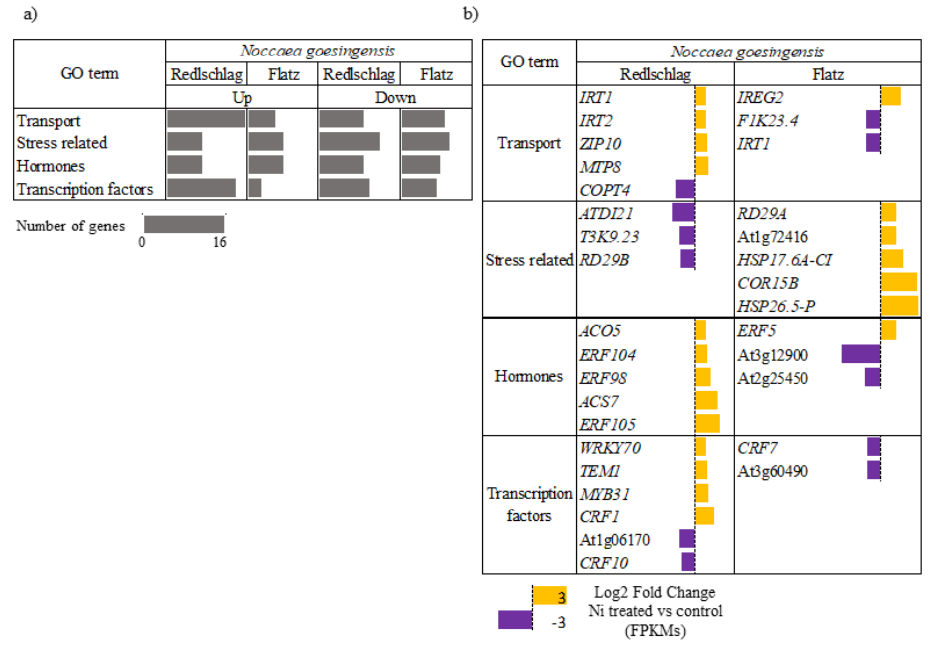
Figure 4. Gene expression analysis of two Noccaea goesingensis ecotypes in response to Ni treatment. ( a ) number of differentially expressed genes classified to four functional categories; ( b ) schematic representation of selected genes from each functional category showing their log2 FC of expression after Ni treatment regarding control.